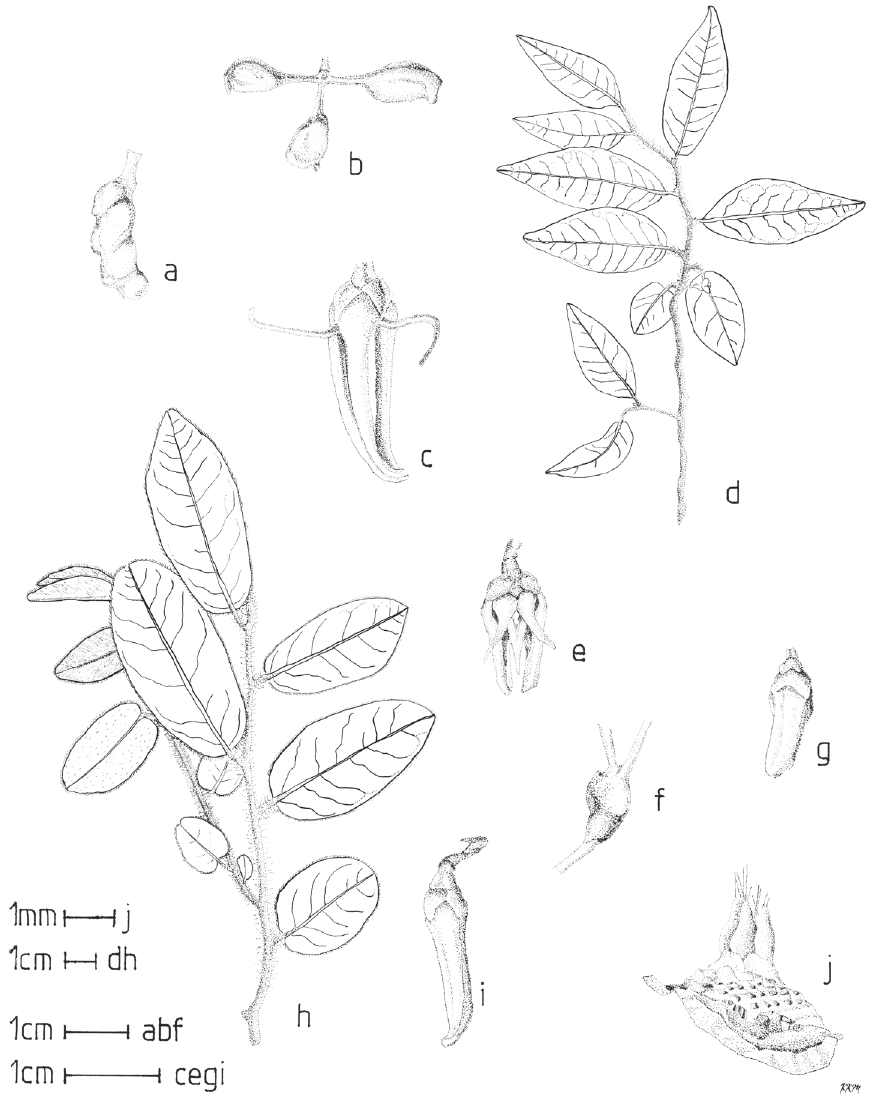
Figure 21. Xylopia collina and X. arenaria . A, C, F, H, I, J X. collina . A Monocarp, lateral view C Flower, lateral view F Stem gall H Habit I Bud J Torus with attached ovaries, lateral view B, D, E, G X. arenaria B Fruit D Habit E Flower bud with one outer petal removed, lateral view G Bud. A, F, H from Johnson et al. 1914 (OWU) B from Johnson & Murray 1890 (OWU) C, I, J from Johnson et al. 1913 (OWU) D, E, G from Johnson et al. 1937